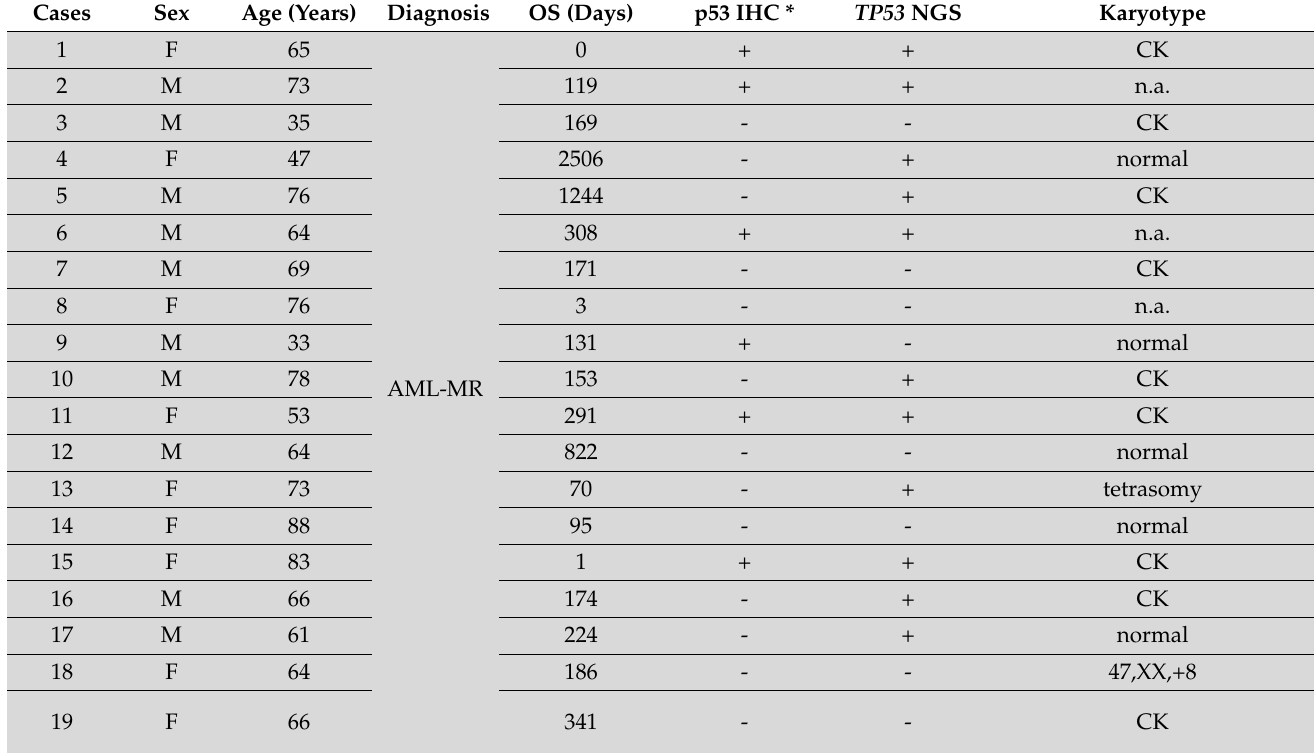
Table 1. Clinicopathological results and overall survival (OS) of the